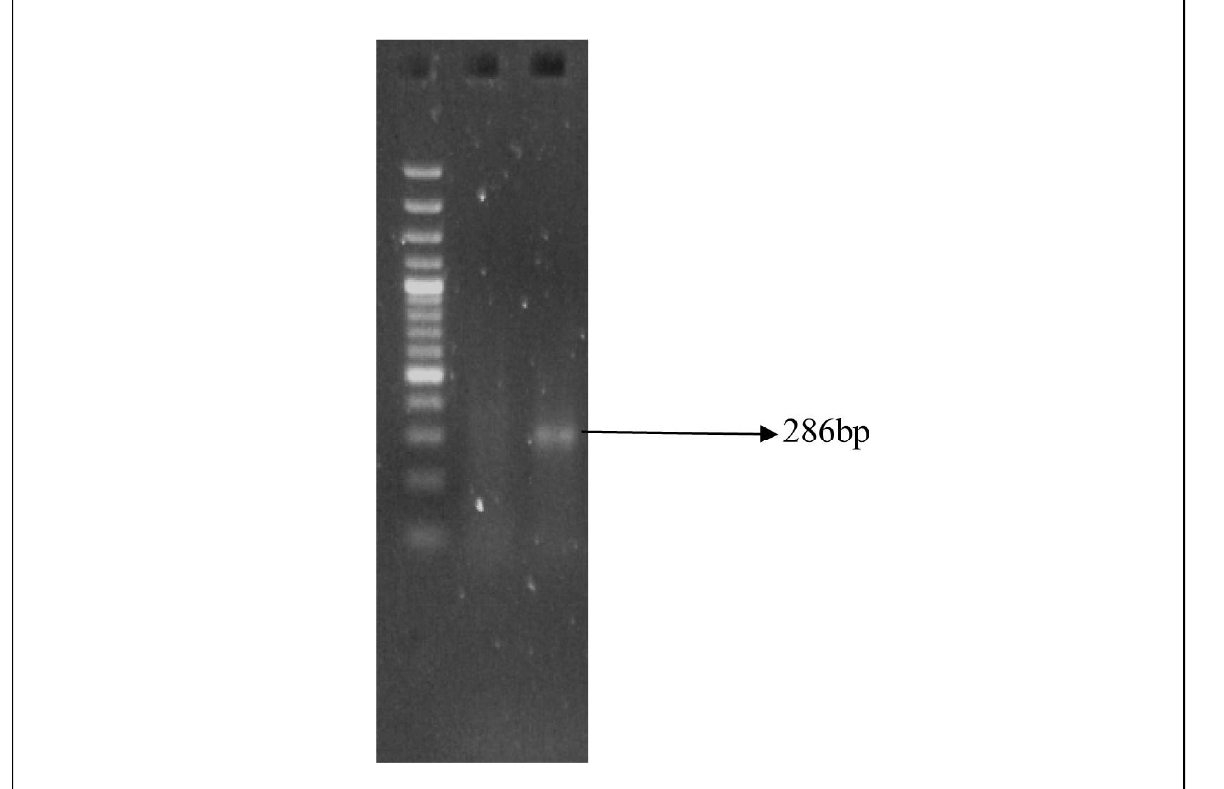
Figure 2: Isolates possessing aac(3)-IV gene confirming resistance to gentamycin